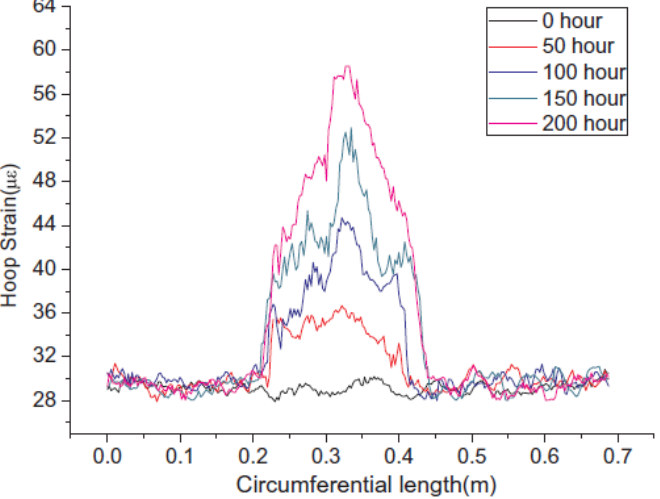
Figure 34. The hoop strain distribution of one optical fibre measured at a 50-hour-interval. Reprinted from Measurement, Volume 122, Ren, L.; Jiang, T.; Jia, Z.; Li, D.; Yuan, C.; Li, H. Pipeline Corrosion and Leakage Monitoring Based on the Distributed Optical Fiber Sensing Technology, Page 57–65, Year 2018 with permission from Elsevier